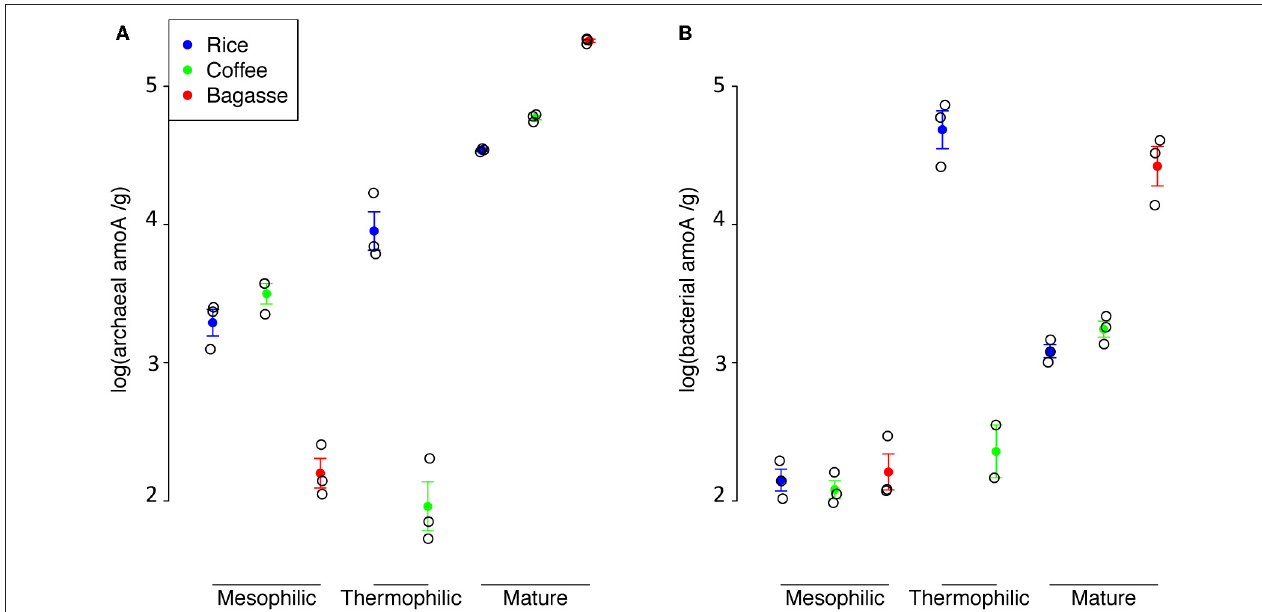
FIGURE 3 | Abundance of archaeal amoA genes (Panel A) and bacterial amoA genes (Panel B) in each compost as a function of phase. Solid circles are the average values for triplicate qPCR runs, open circles are values for an individual qPCR run and bars indicate the standard